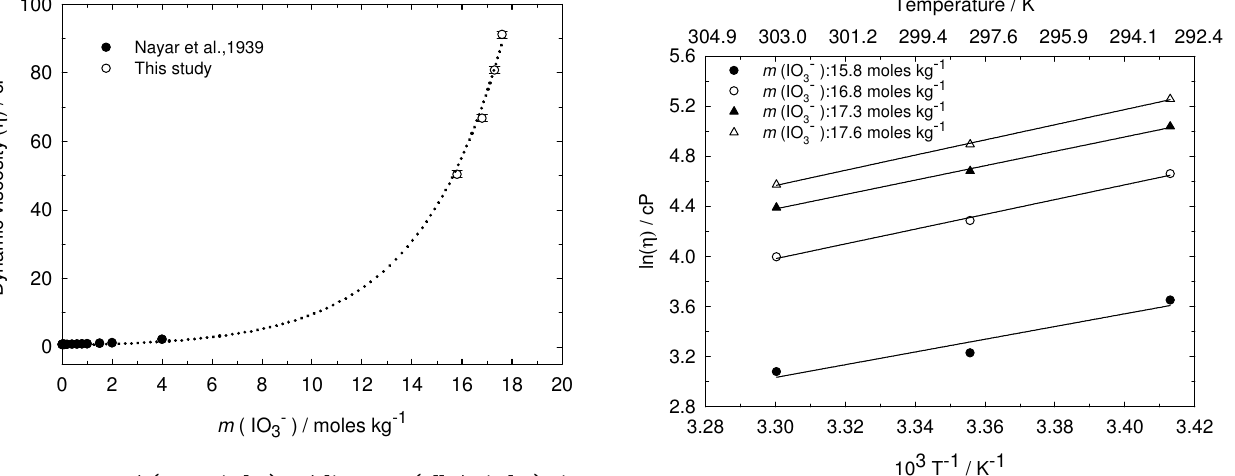
Fig. 4. Measured (open circles) and literature (filled circles) vis- cosity data for aqueous iodate solutions at 303K, as a function of m (IO − ). Our data is shown in addition to data from the literature 3 (Nayar et al., 1939). The dotted line is a least-squares exponential fit ( η [cP] = 0 . 798exp { 0 . 267 × m } ) through all data points.